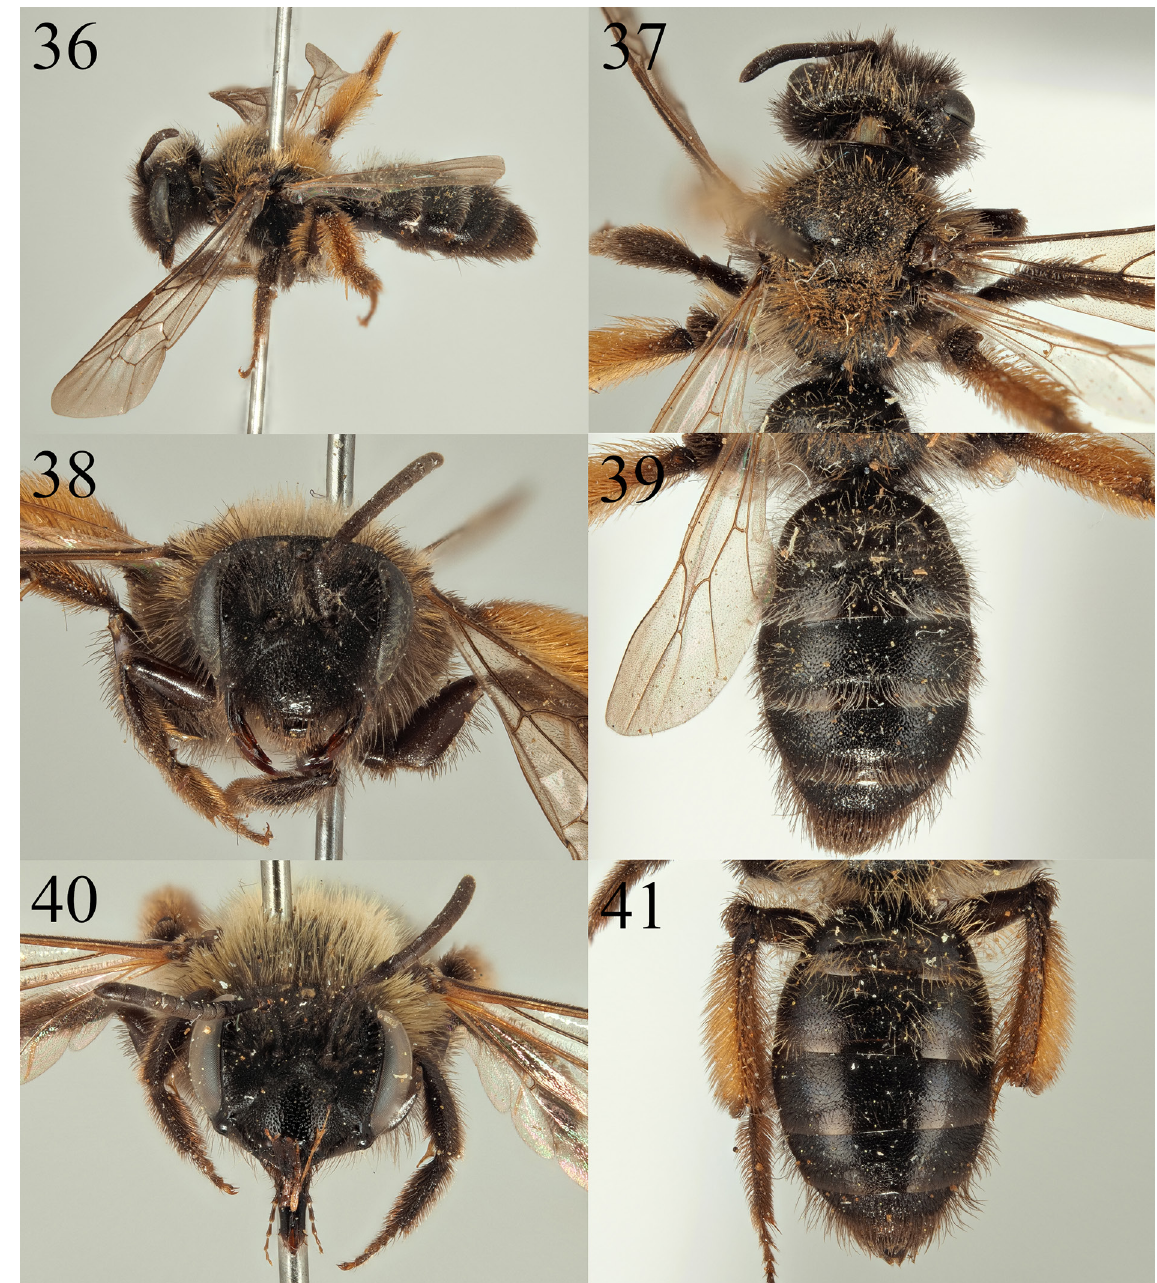
Figs 36–41. 36–39. Andrena fortipunctata Wood sp. nov. (NMNL). 36 . Female profile. 37 .